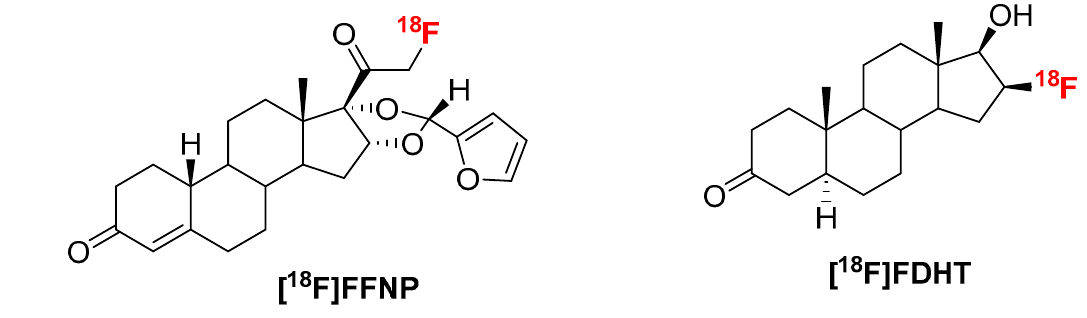
Figure 1. Structures of [ 18 F]FFNP and [ 18 F]FDHT.